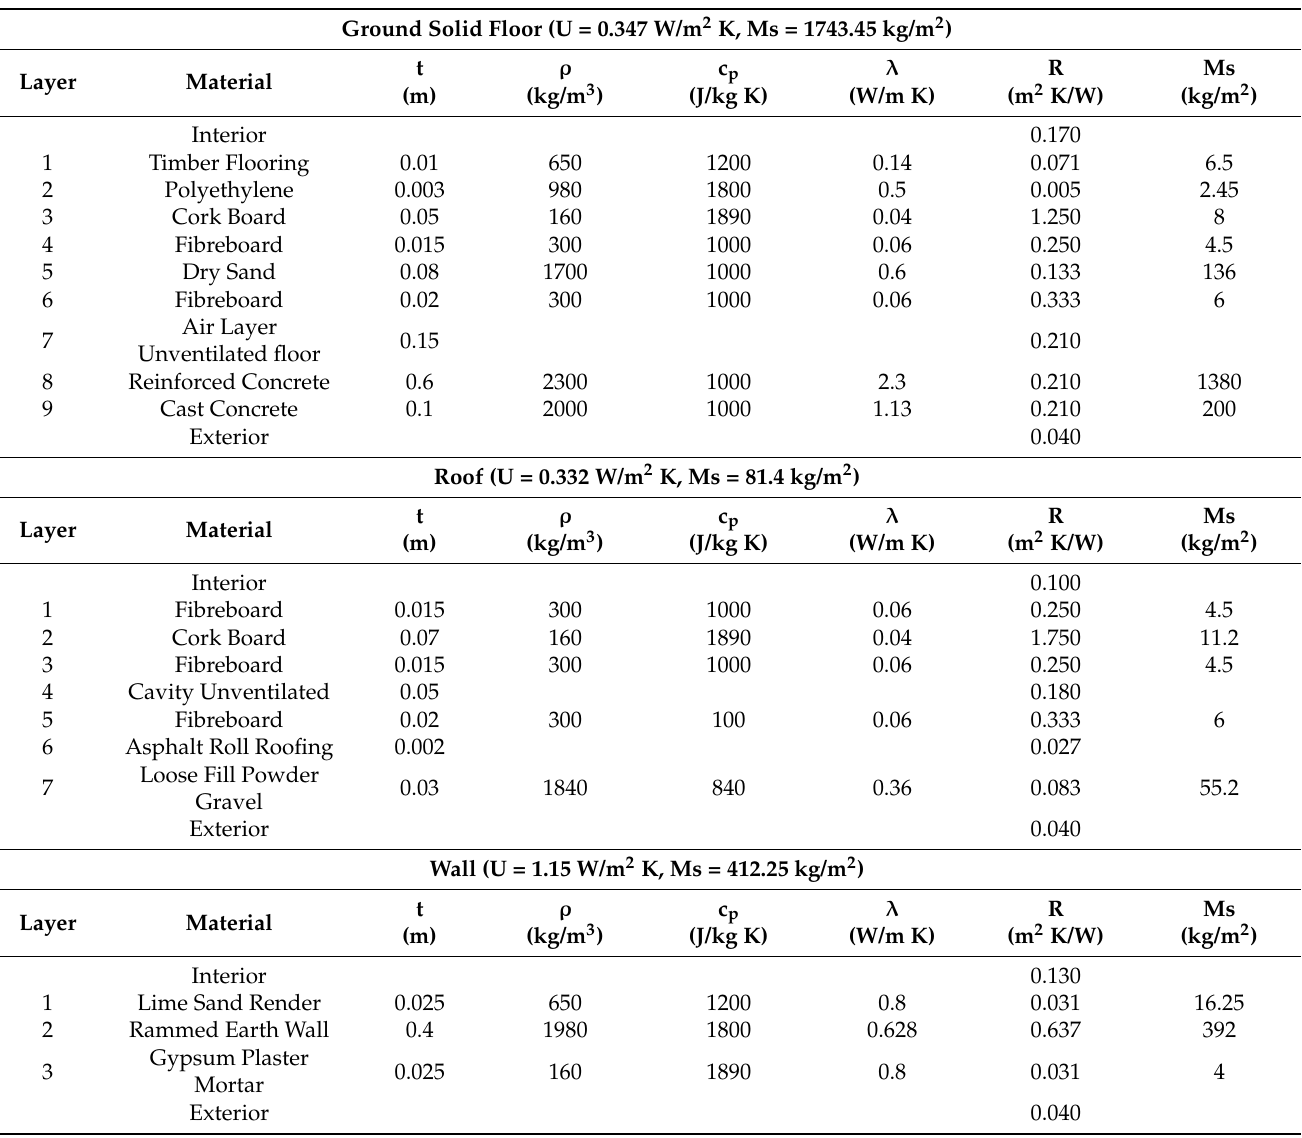
Table 3. Basic constructions of the building